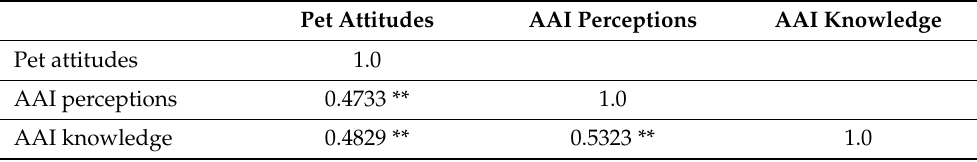
Table 4. Correlation between AAI perceptions, pet Attitudes, and AAI